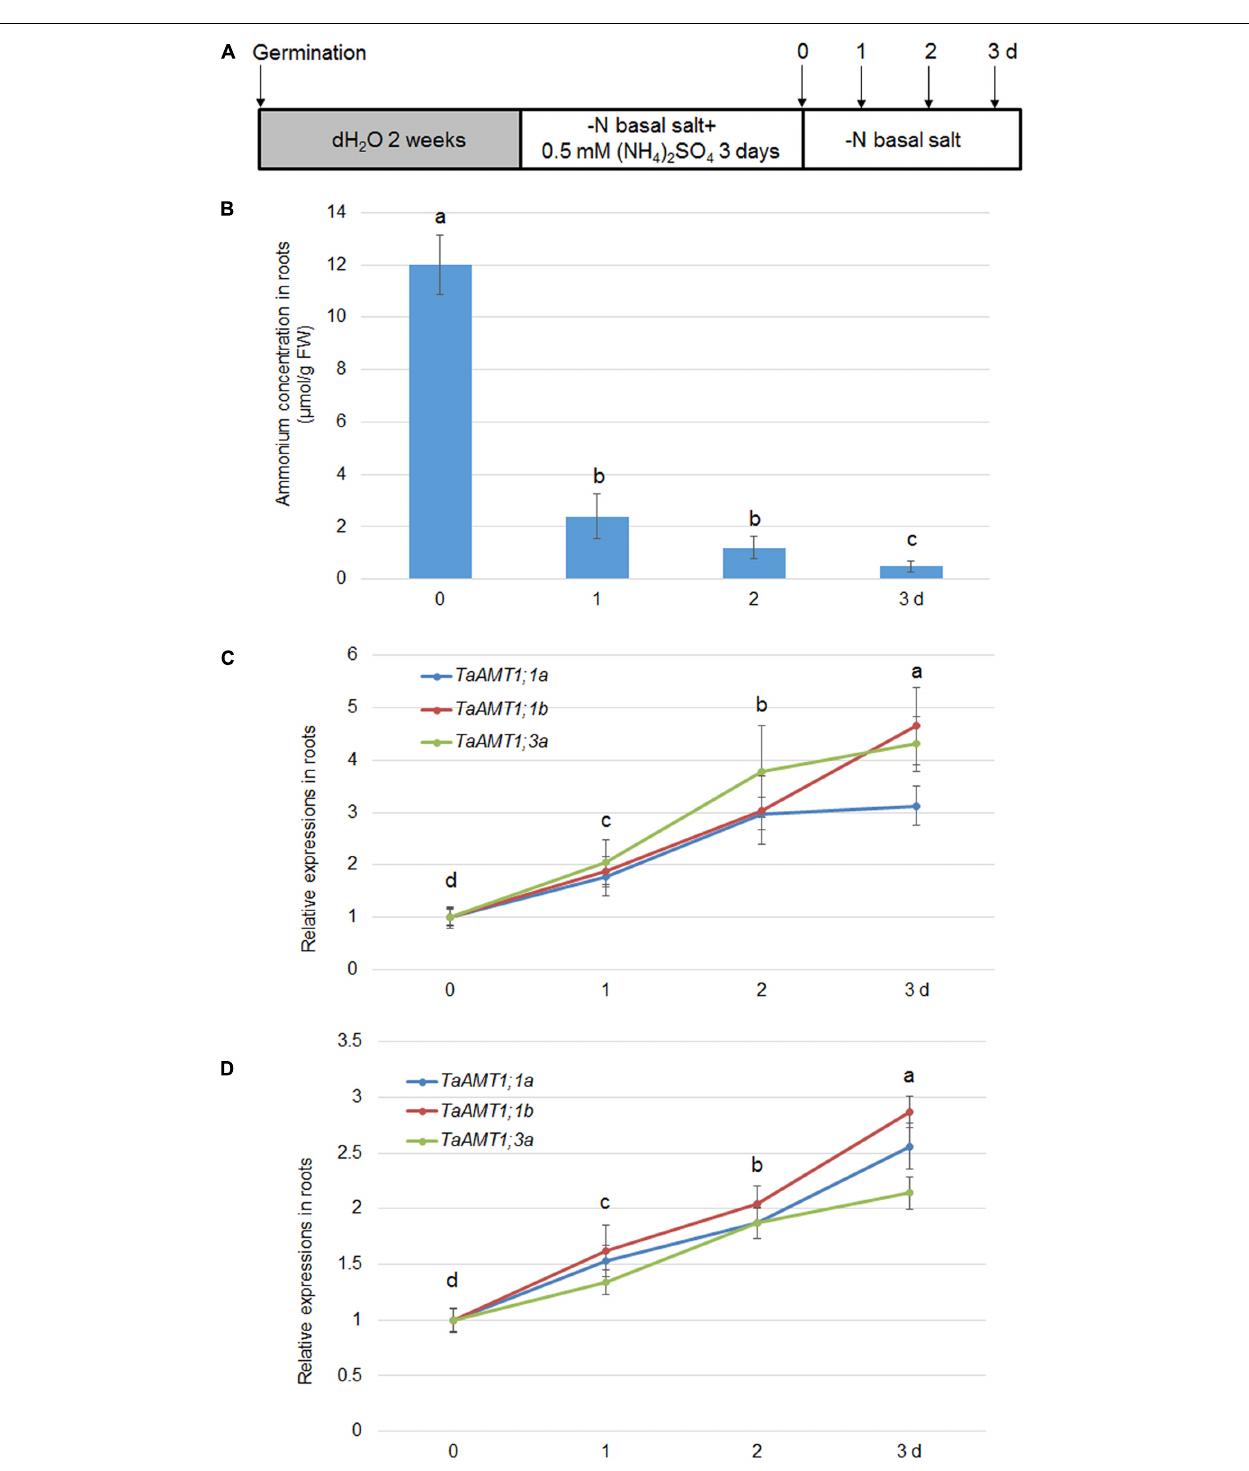
Frontiers in Plant Science |